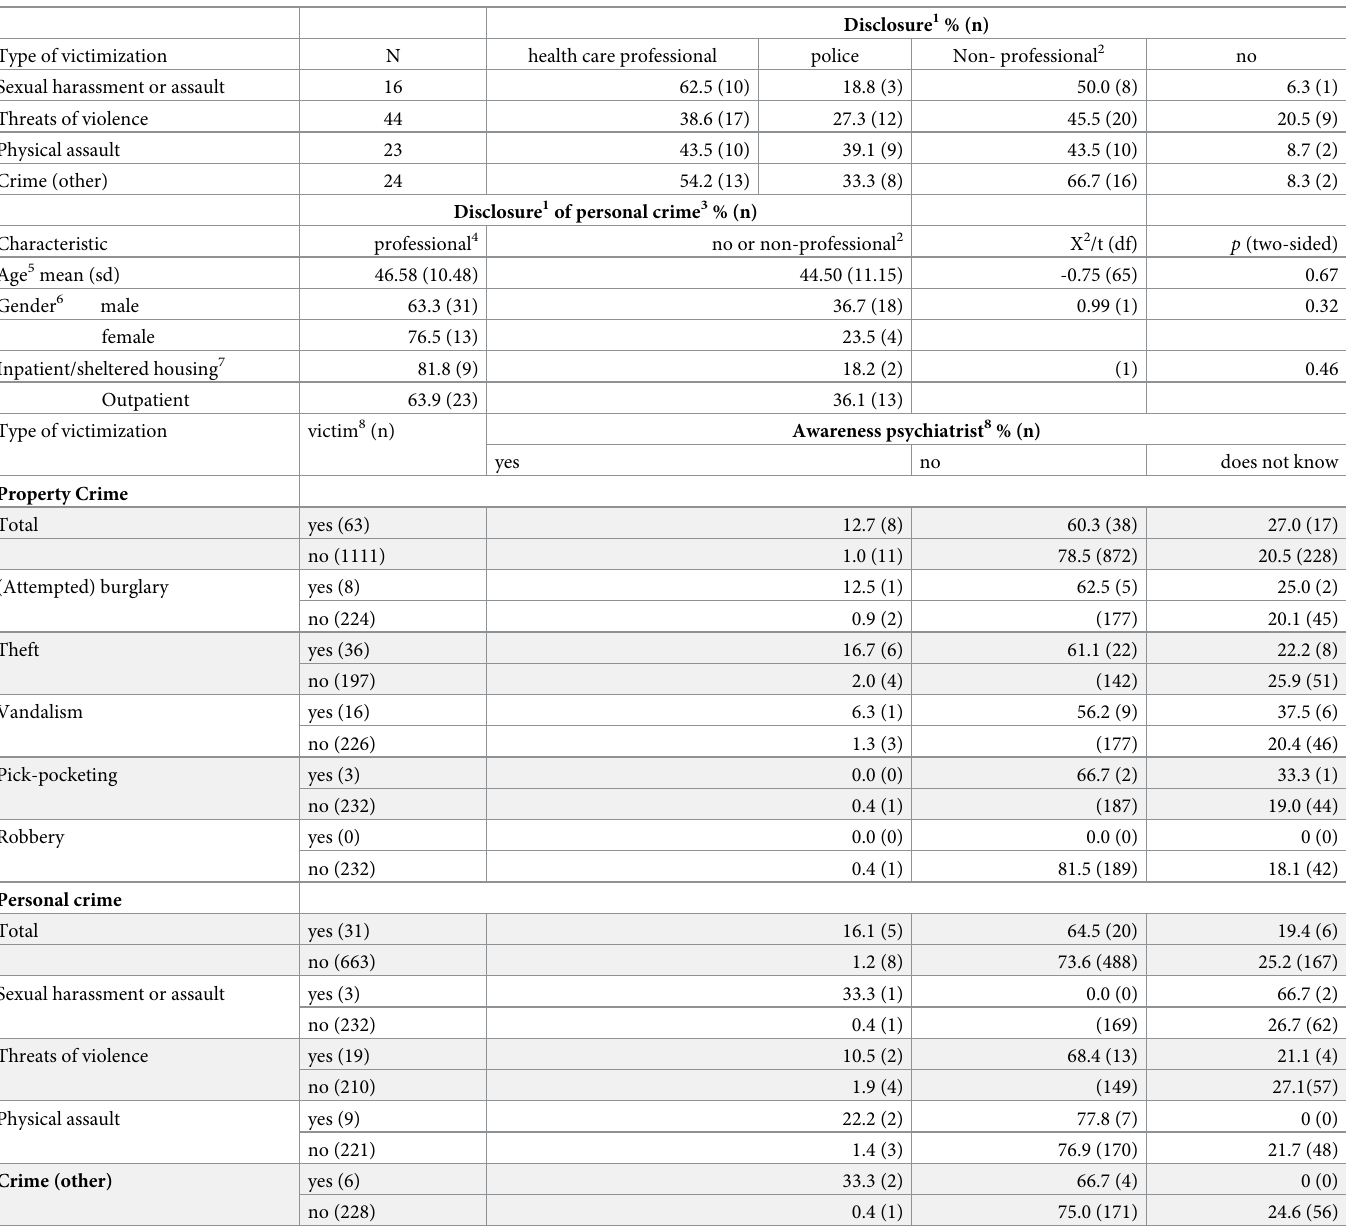
Table 3. Disclosure of victimization and awareness of the